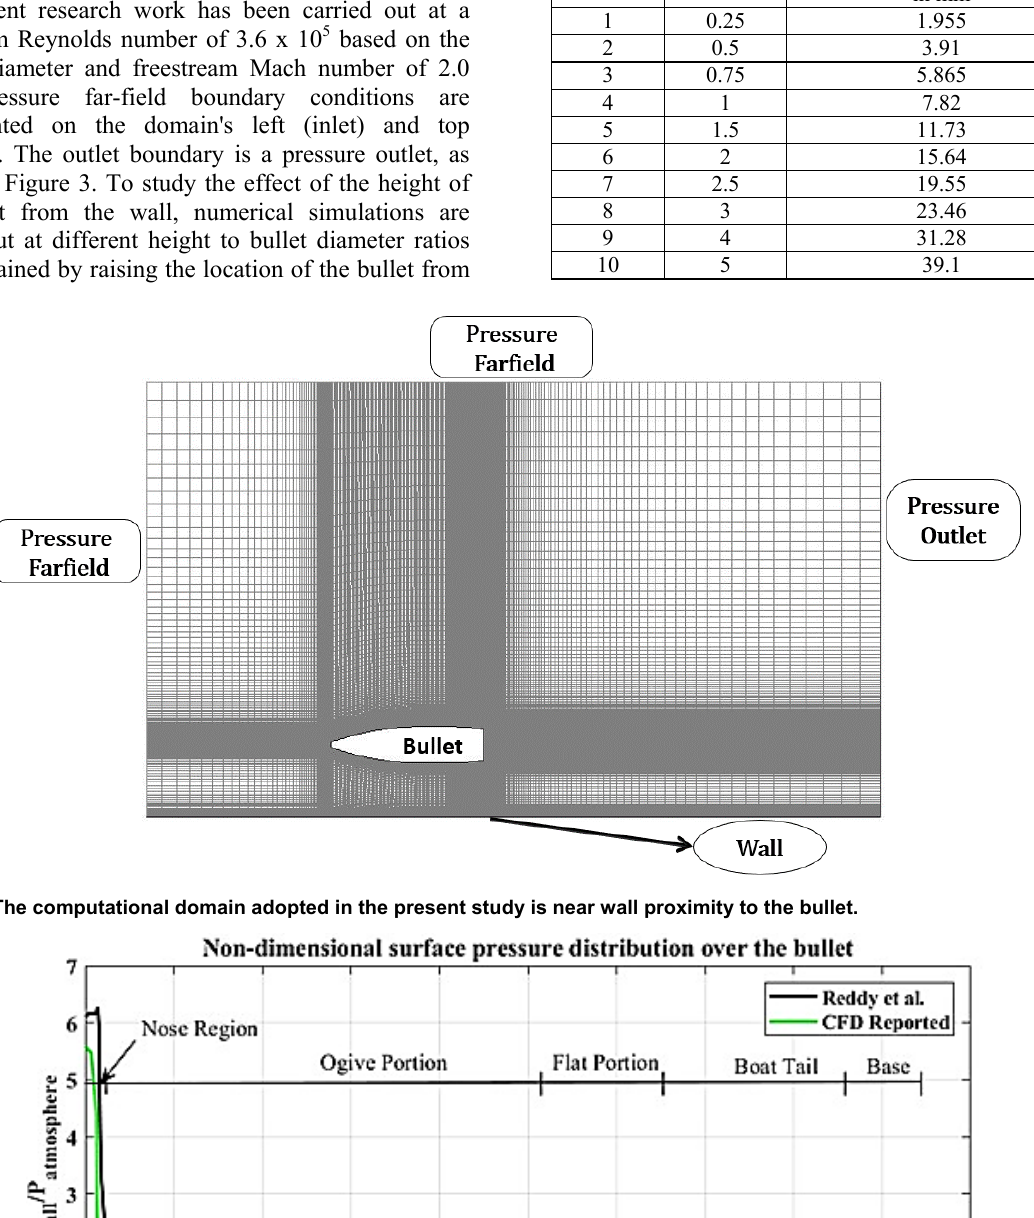
Table 1: Different h/D ratios from 0.25 to 5 adopted in the present investigation Sr. No.